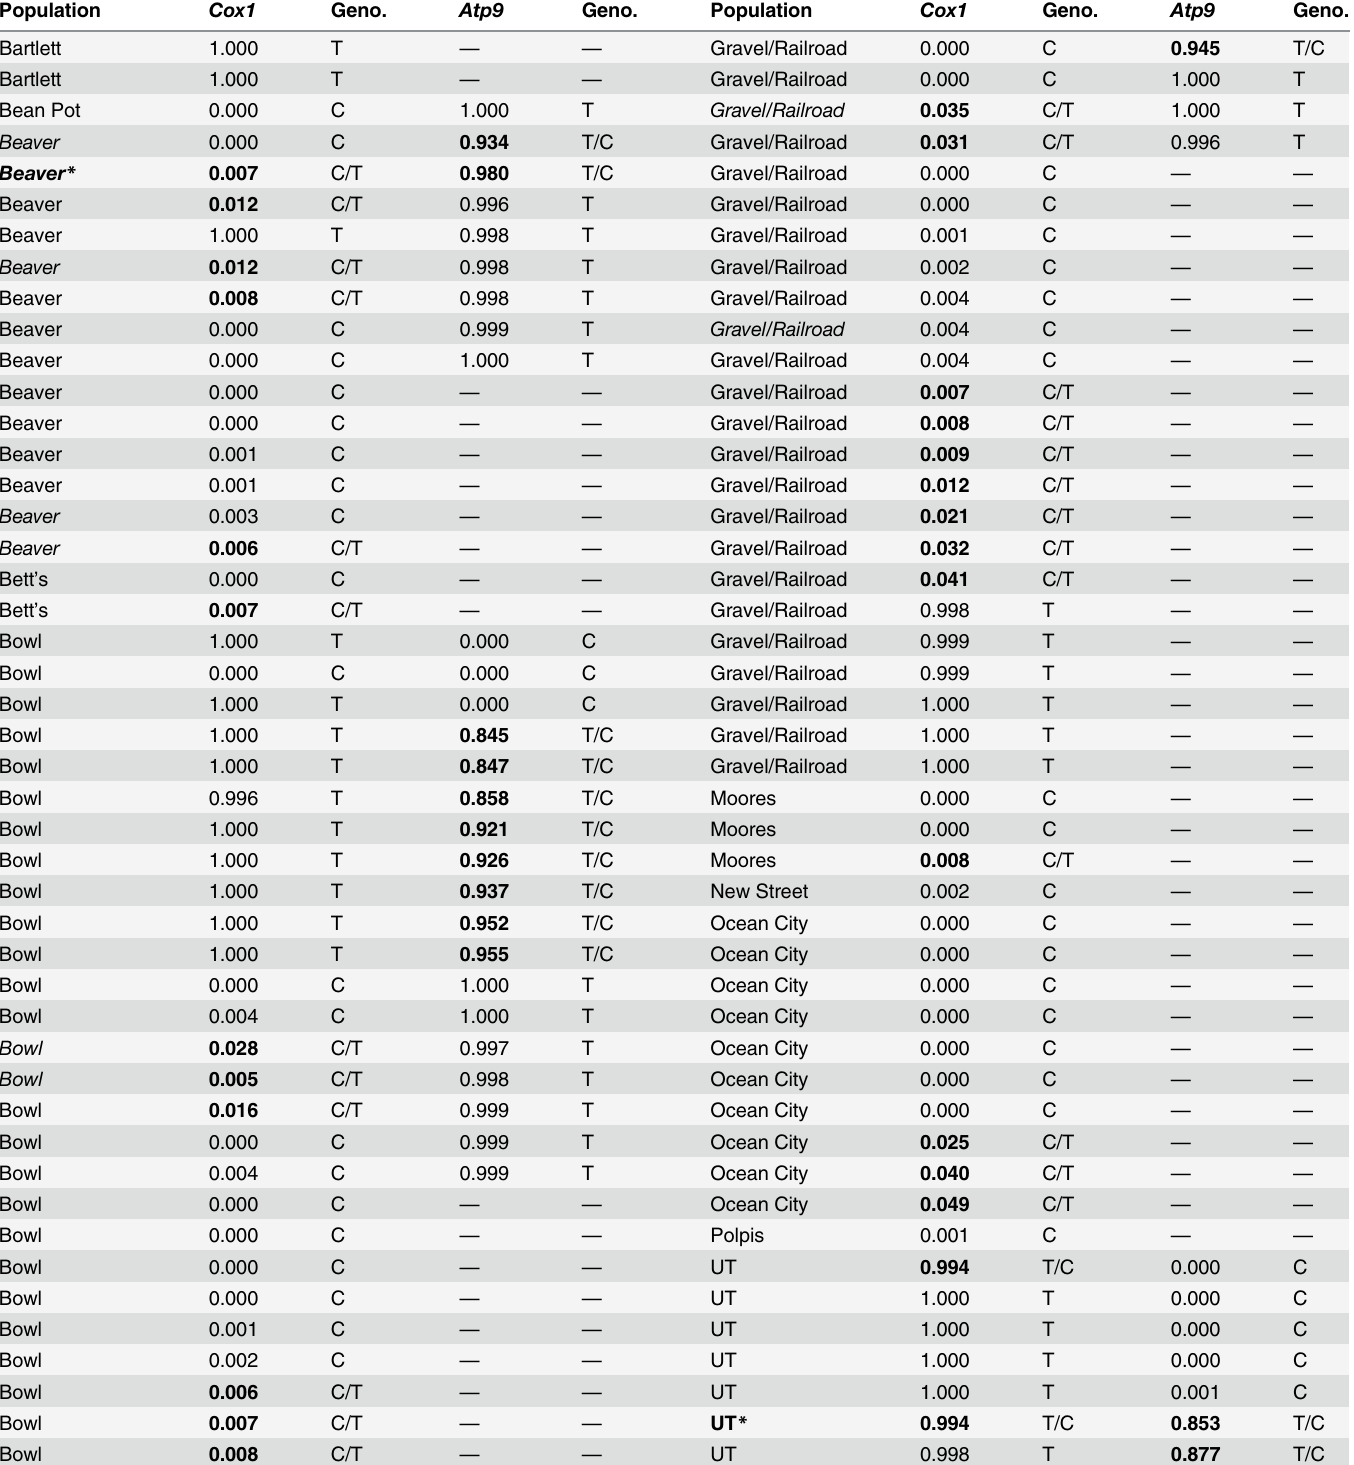
Table 2. Heteroplasmy scores and SNP genotypes for 140 Cox1 and 50 Atp9 individuals as given by relative proportion of the T SNP for both